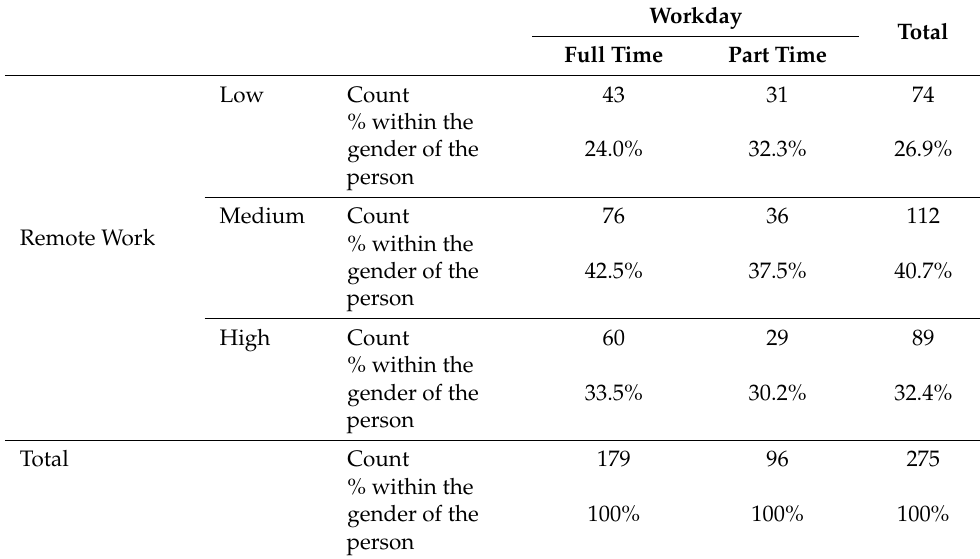
Table 15. Cross table of the level of remote work and working hours.